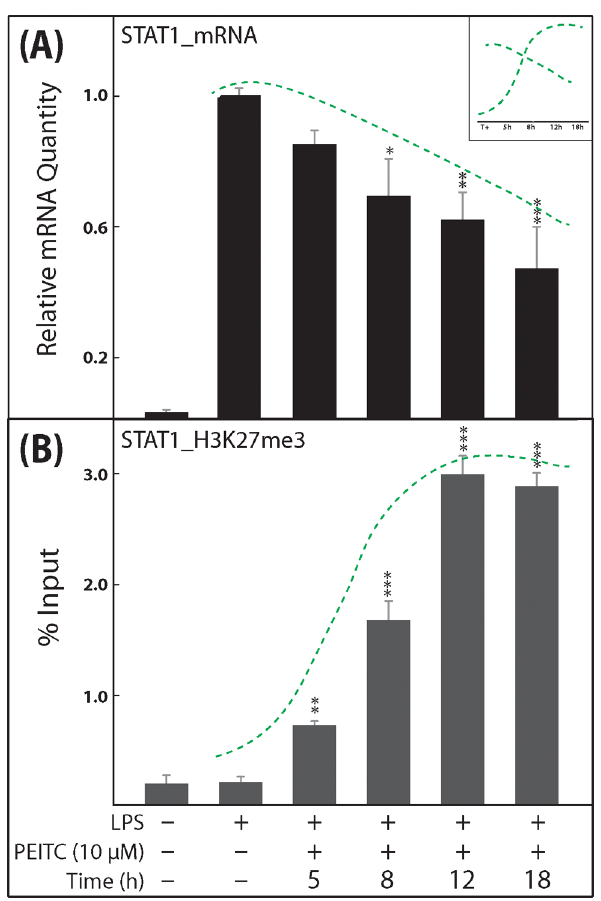
Figure 5. Representative results showing the time-dependent effects of 10 m M PEITC treatment on STAT1 mRNA levels and on the H3K27me3 methylation state. SW480 cells were treated with 10 m M PEITC at the indicated time points (A, B). The STAT1 mRNA levels were normalized to GAPDH levels and expressed as a percentage relative to positive-control cells (A). Histone H3 methylation changes at the STAT1 promoter region in SW480 cells were determined using an anti-H3K27me3 antibody for ChIP. DNA sequences were quantified by real-time PCR (B). Data points represent the mean 6 SEM (n=4) from each experiment. *p , 0.05, **p , 0.01, ***p , 0.001 compared with positive-control cells. The green dotted lines indicate a possible inverse correlation (for repressive marks) between changes in mRNA levels and H3 modification status in the cells. The presence or absence of similar correlations for the remaining five GoI are shown in Figures S1, S2, S3, S4, S5.